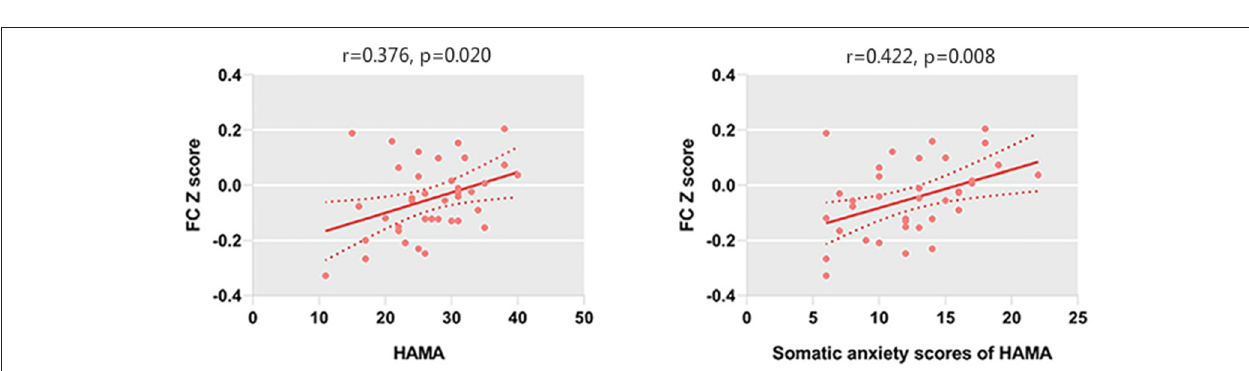
FIGURE 3 | HAMA scores and somatic anxiety scores of the HAMA are positively correlated with the FC between the right amygdala and right